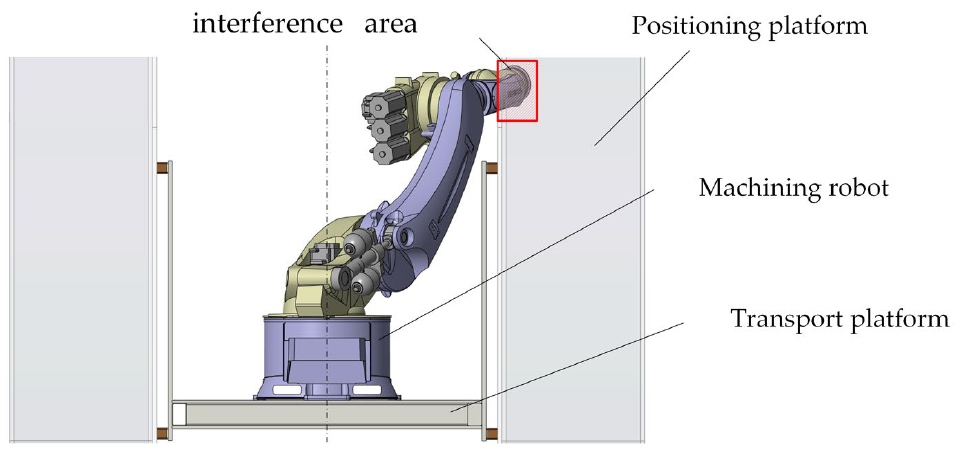
Figure 5. The consequence of excessive rotation angle of the robot A1-axis.